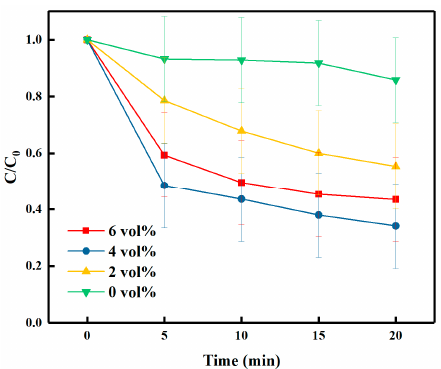
Figure 7. Effect of H 2 O 2 loading on the catalytic degradation of MB without ultrasonication. Experimental conditions: [MB] = 25 ppm, [catalyst] = 1 g/L mg, [H 2 O 2 ] = 0–6 vol %.